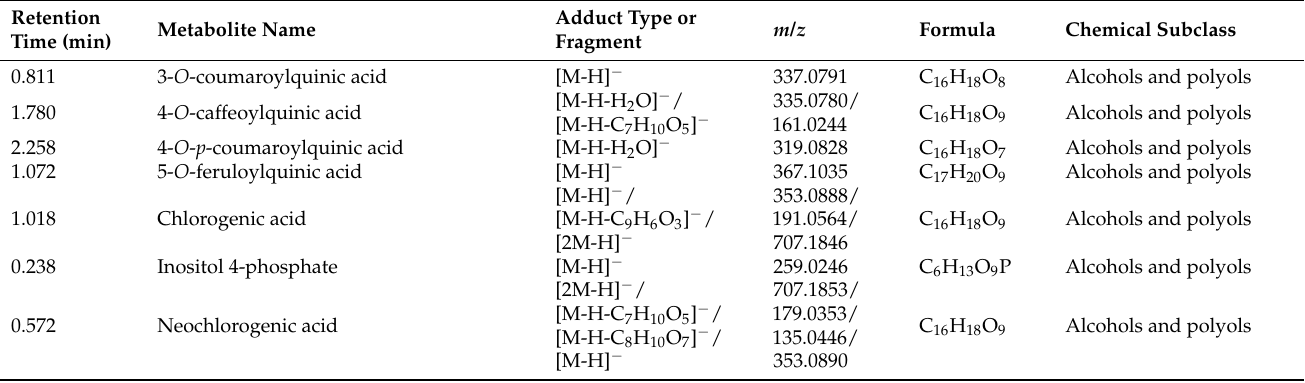
Table 5. Tentatively identified metabolites in all thinned peach PLE extracts using